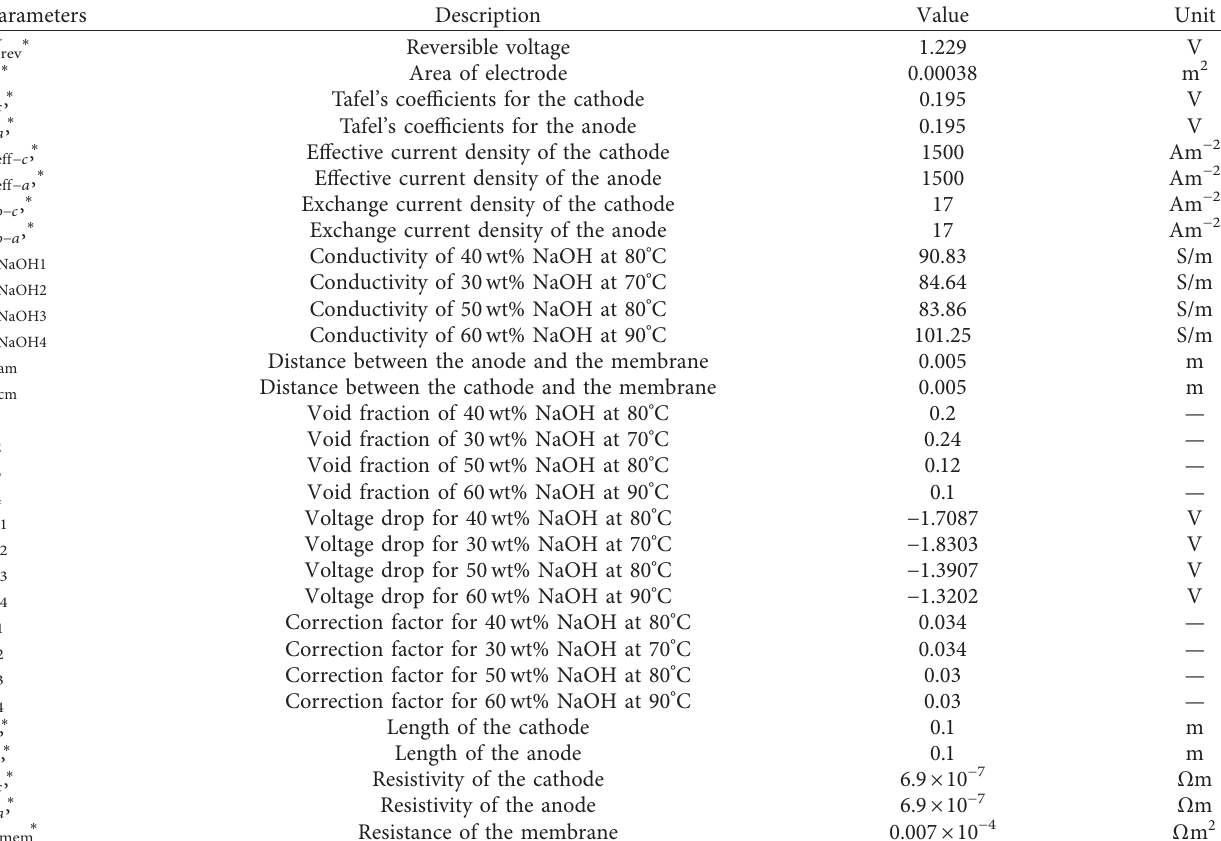
Table 5: Parameters for the different electrolyte concentrations.